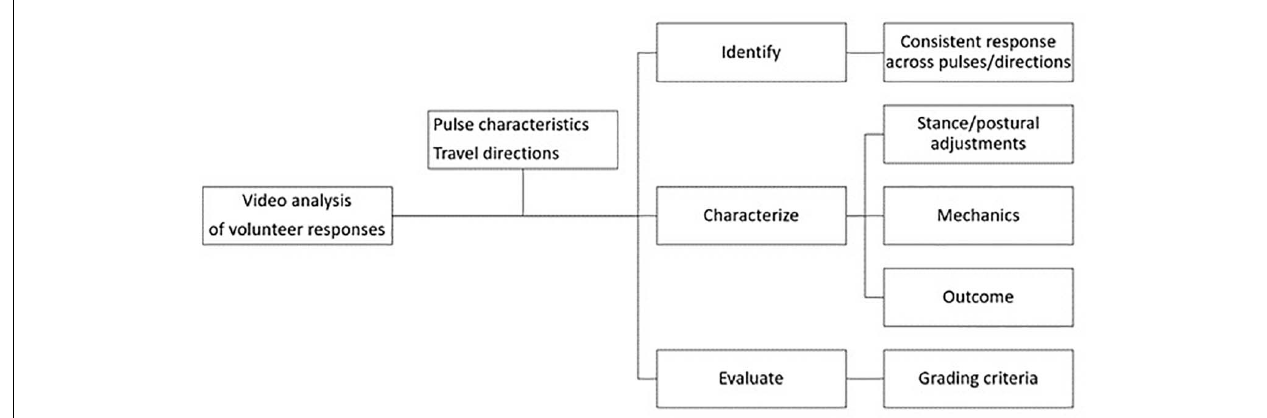
FIGURE 1 | Analysis